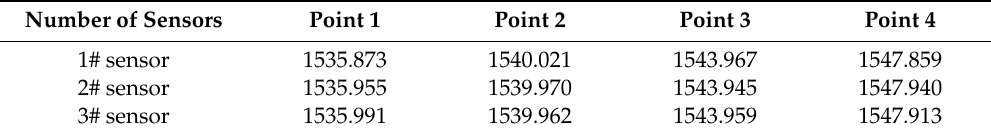
Table 2. Initial wavelength of each measurement point of the FBG temperature